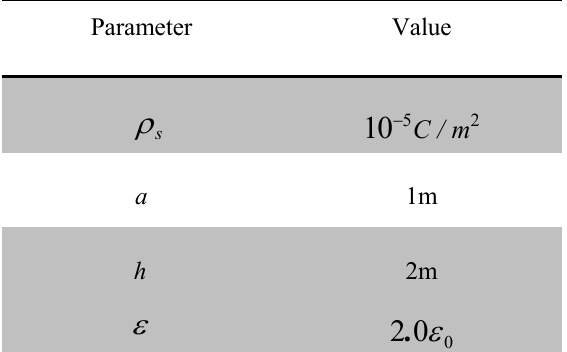
Table 1. Parameters for Poisson’s Equation in Axisymmetric Homogeneous